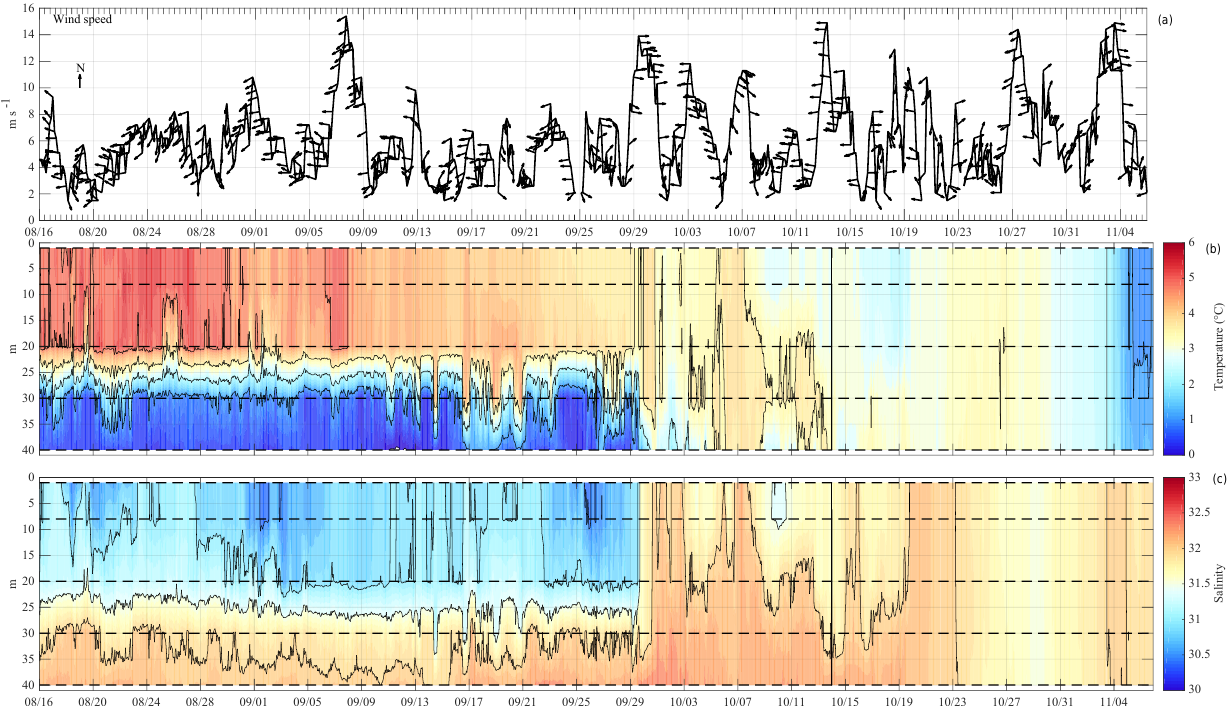
Figure 5. Time series from the NOAA-operated Wiley Post-Will Rogers Memorial Airport weather station and the Chukchi Ecosystem Ob- servatory freeze-up detection mooring deployment in 2015. Shown are (a) wind speed and direction (arrows pointing downwind), (b) tem- perature ( ◦ C), and (c) salinity. Conductivity and temperature sensors were moored at 8, 20, 30, and 40m (dashed lines) from early September until close to freeze-up at the beginning of